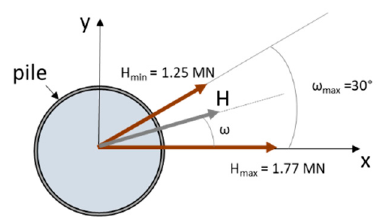
Figure 8. Force applied on the pile head.